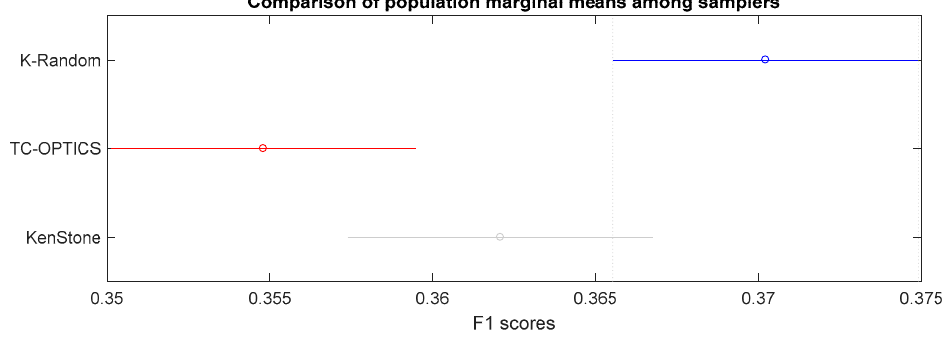
Figure 9. F1 scores for the employed samplers.